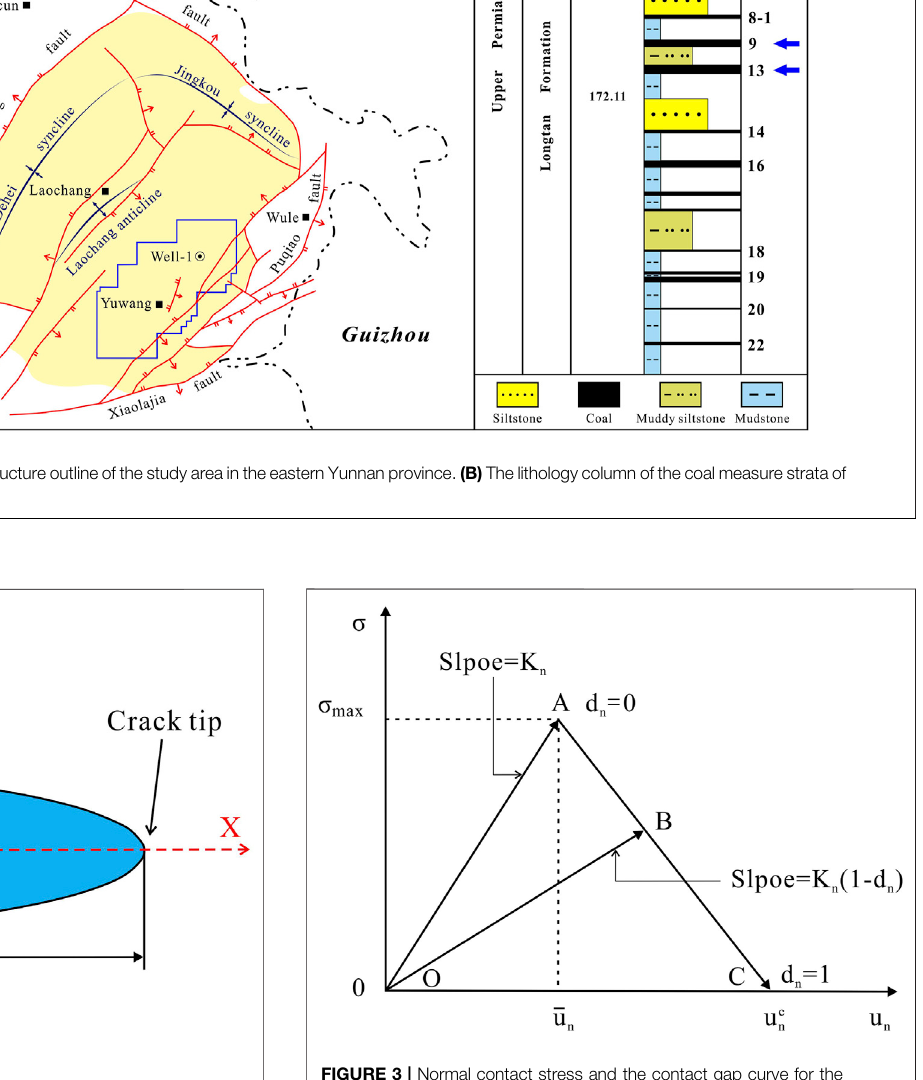
FIGURE 2 | Illustration of fracture propagation during hydraulic fracturing.